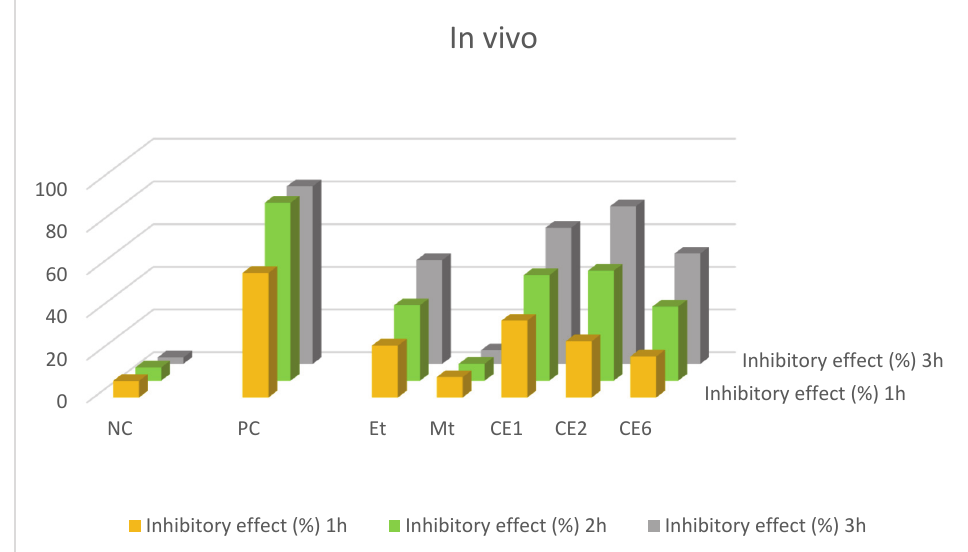
Figure 7. Graphical representation of in vivo analgesic activity.